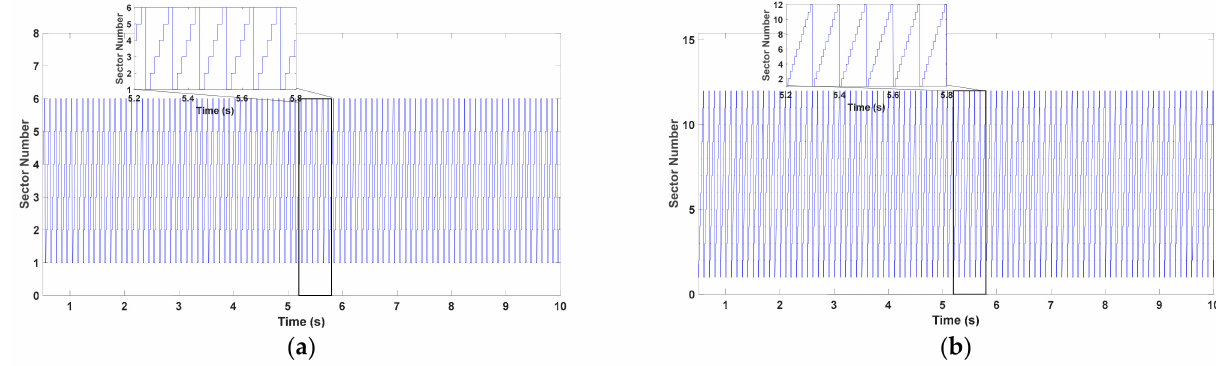
Figure 19. Stator flux sectors with ( a ) 6 − sectors and ( b ) 12 − sectors DTC control